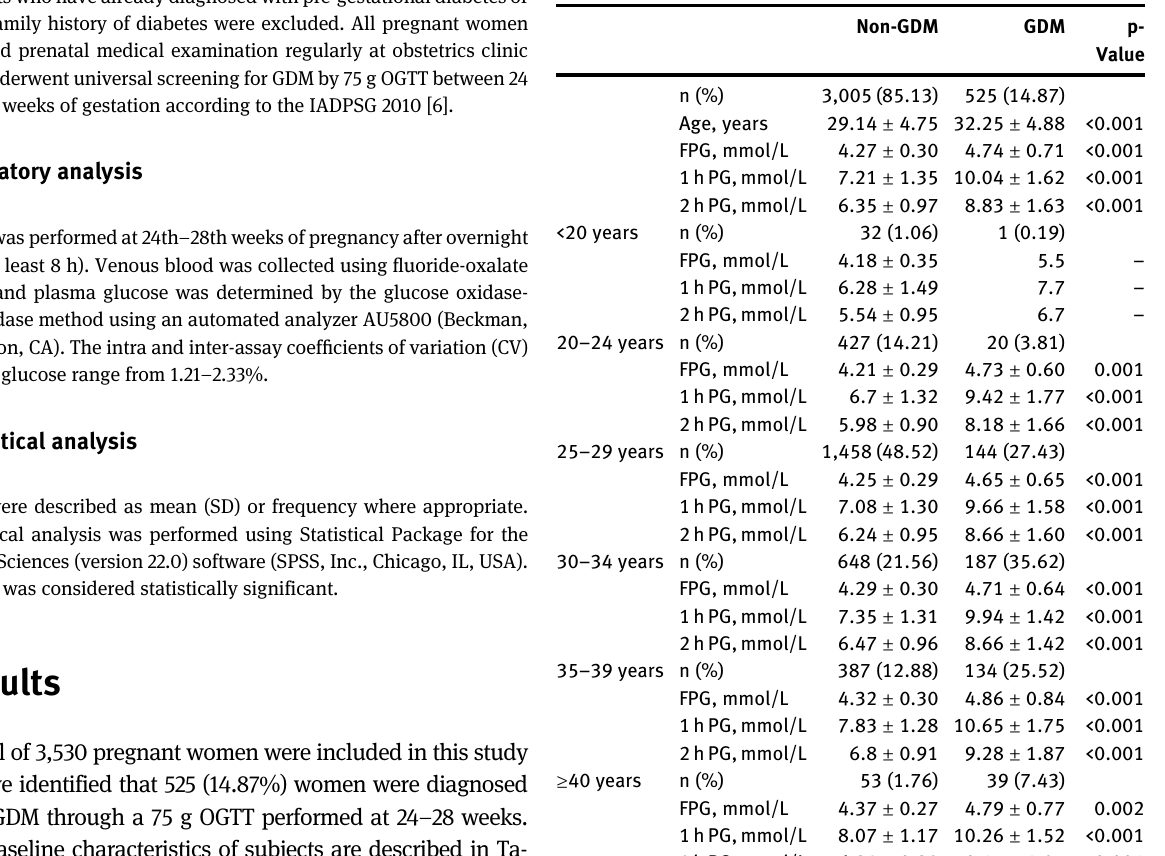
Table  : Characteristics of  ,  pregnant women according to glucose tolerance